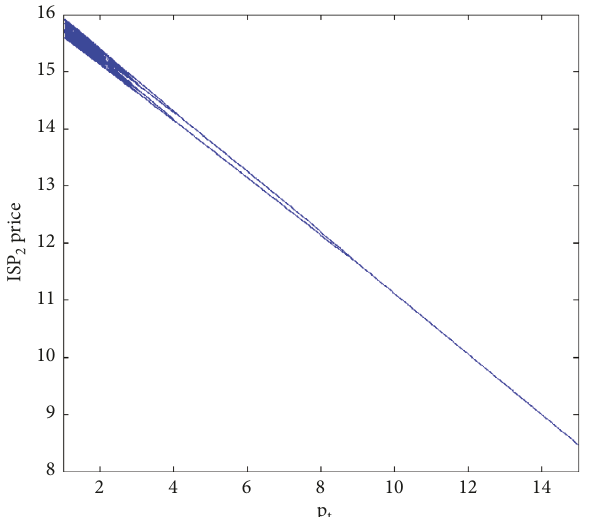
Figure 12: Bifurcation diagrams of p